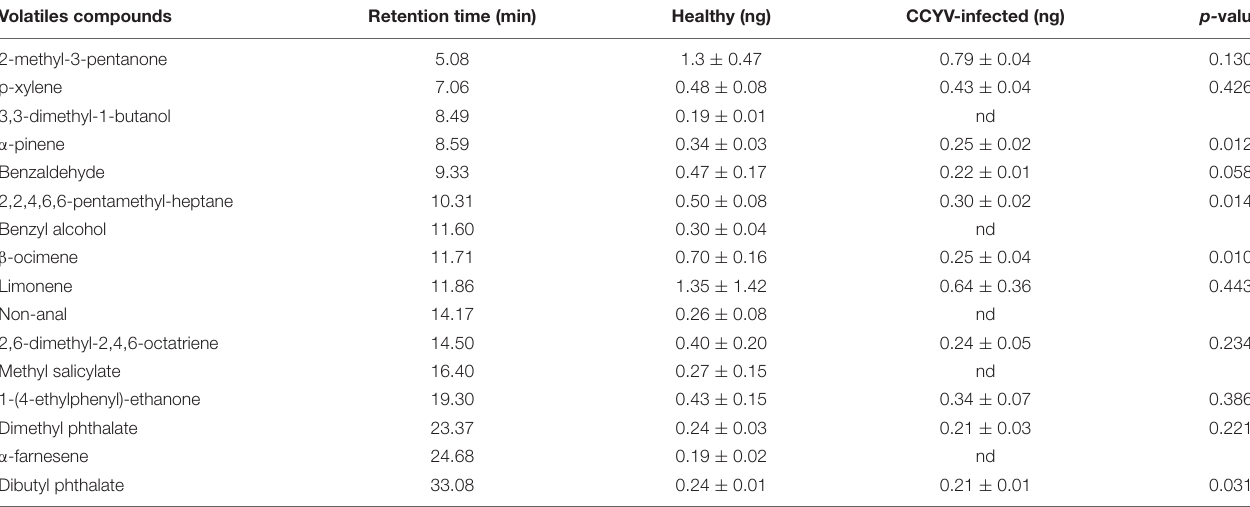
TABLE 1 | Quantification of major volatile organic compounds from healthy and CCYV-infected Cucumis sativus seedlings. Volatiles compounds Retention time (min) Healthy (ng) CCYV-infected (ng) p- value 2-methyl-3-pentanone